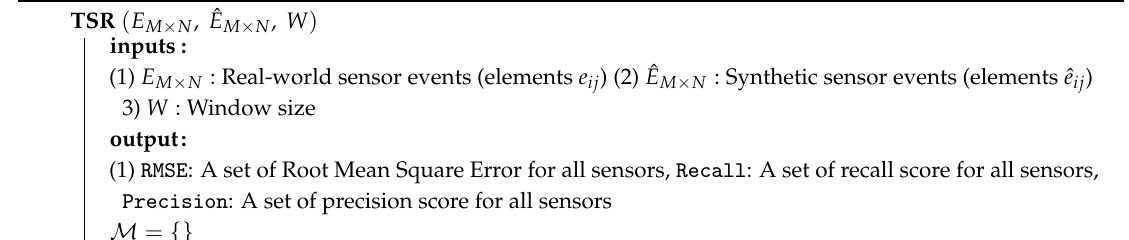
Algorithm 2: Finds a matching list for real-world temporal sensor readings (TSR) regarding a given window size and calculates